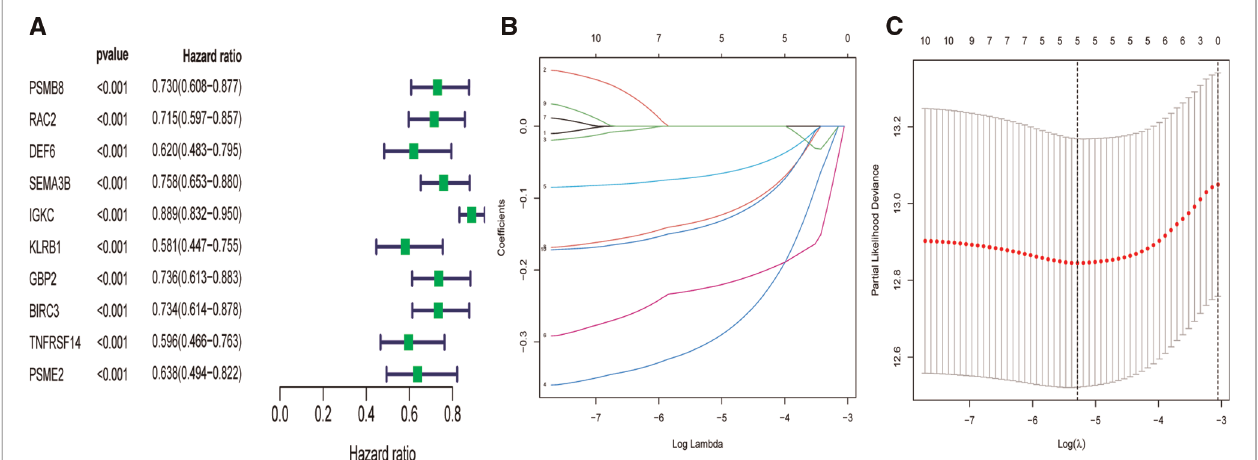
FIGURE 4 | Univariate- and LASSO-Cox analyses based on DEGs between two clusters. ( A ) Univariate Cox analysis of overall survival (OS) and 10 genes with p < 0.001. ( B ) LASSO coef fi cient spectrum of the 10 OS-related genes. ( C ) Cross validation for tuning parameter selection in the LASSO model.